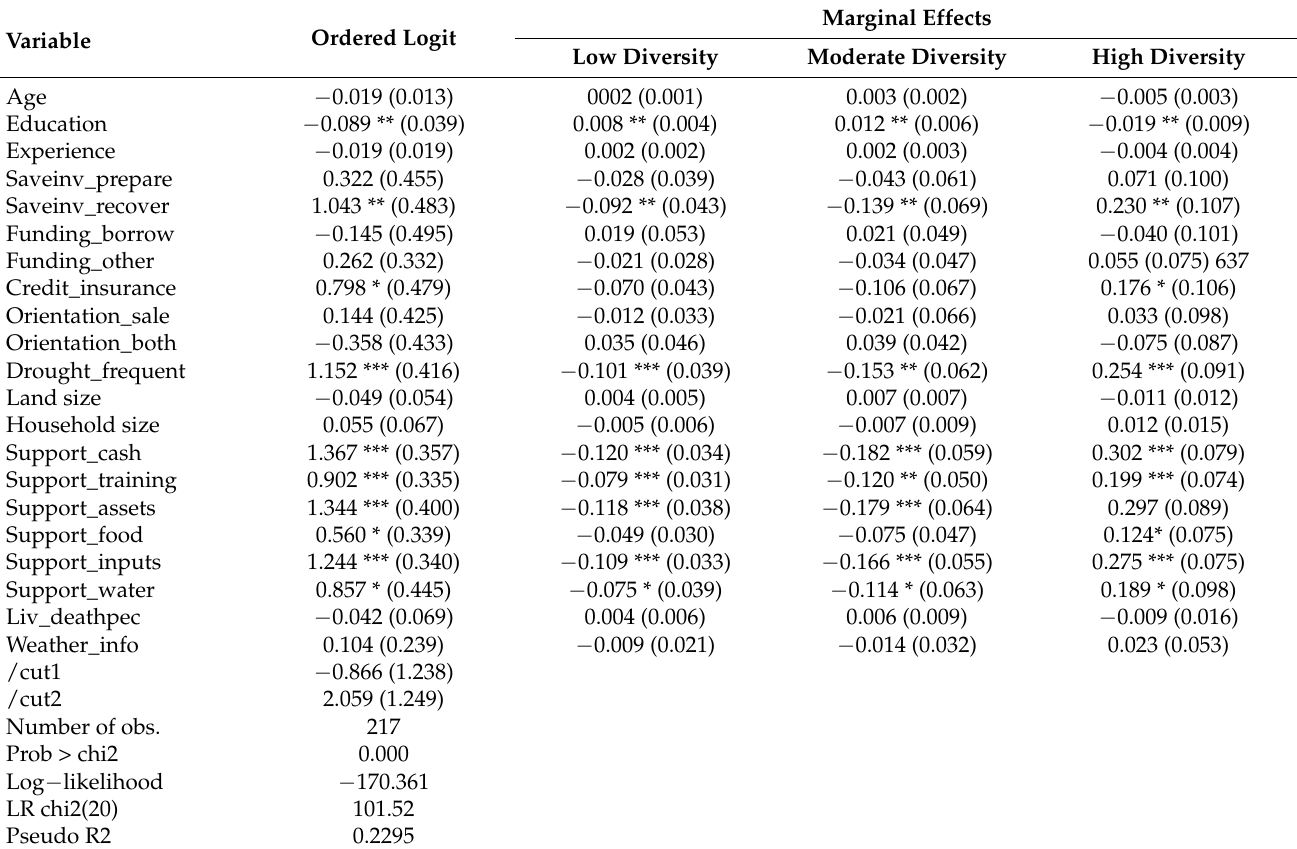
Table 5. Ordered logit regression model results with marginal